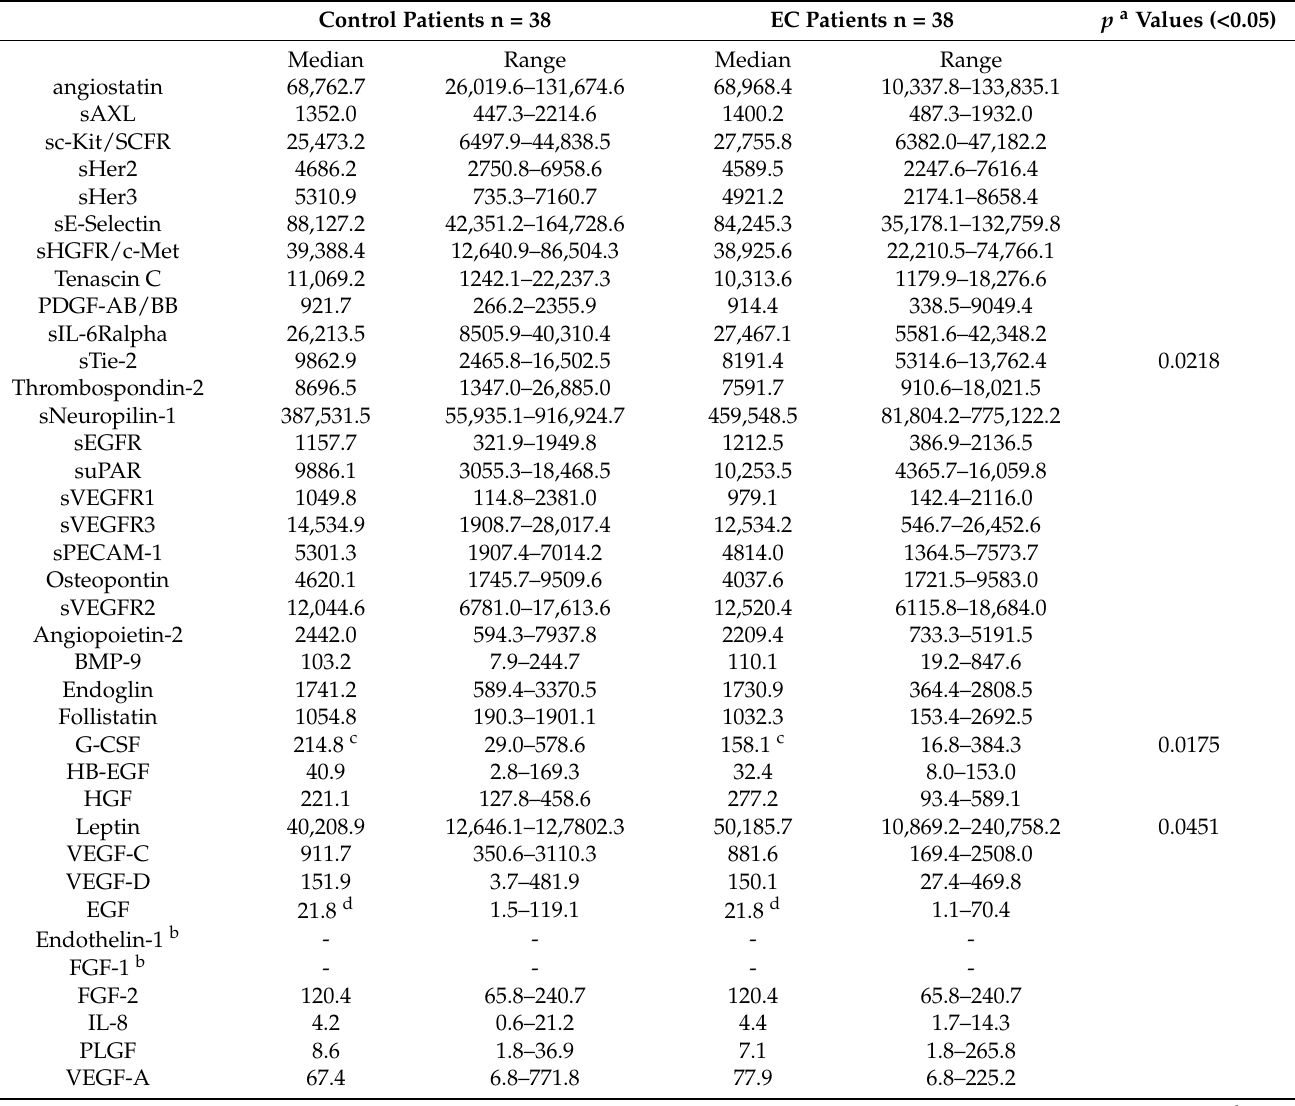
Table 2. Plasma concentrations (pg/mL) of the measured angiogenesis